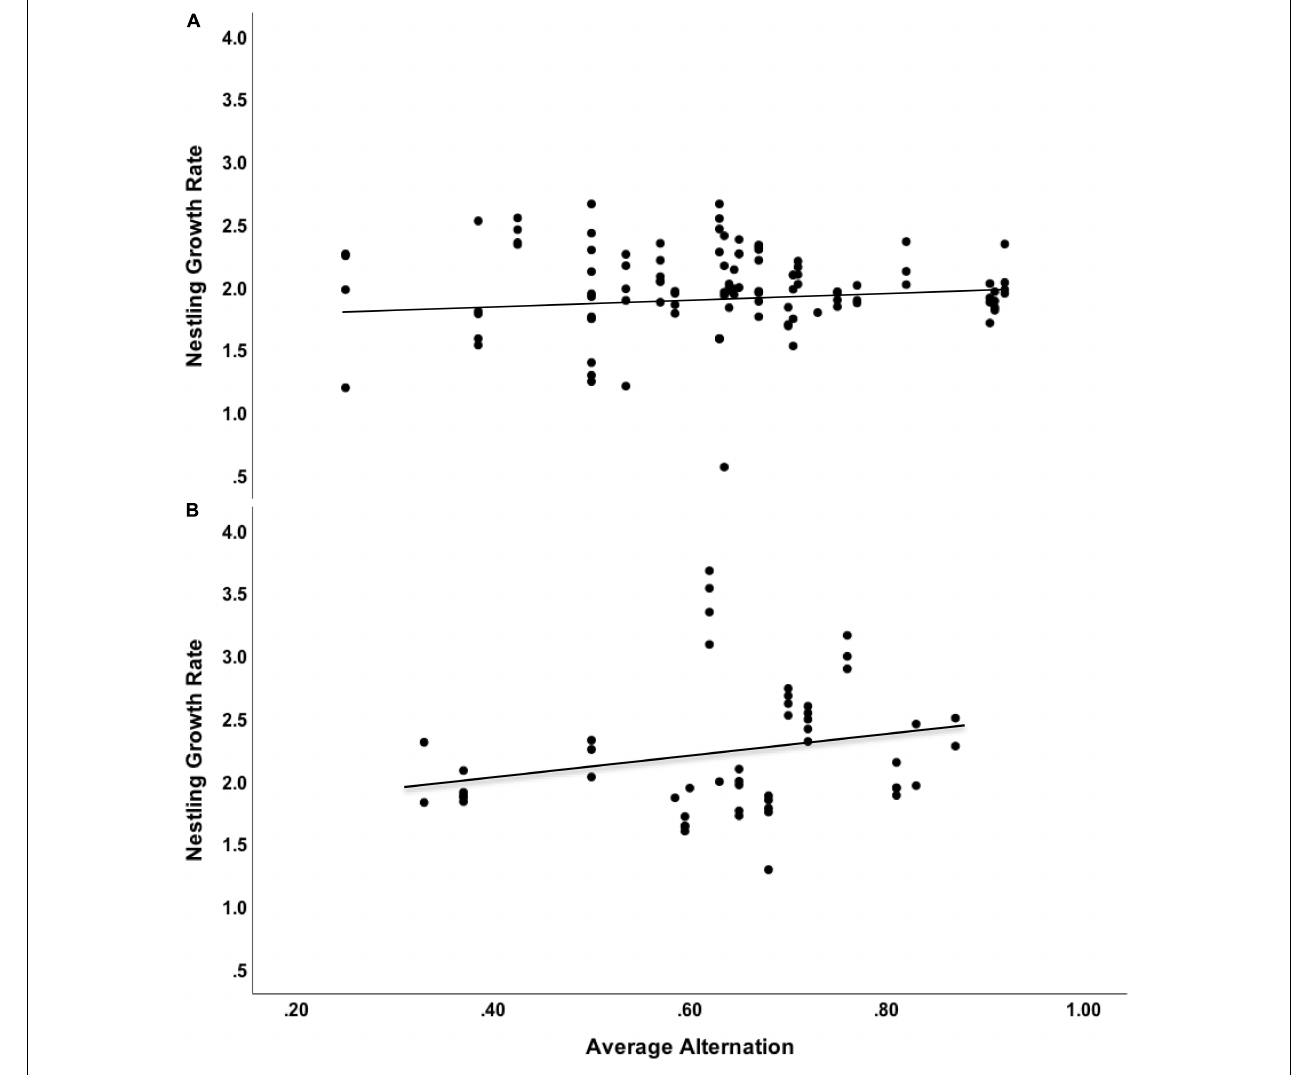
FIGURE 3 | Relationship between average alternation level (proportion of all visits that are alternated within pairs) and nestling growth rate (g/day) of eastern bluebirds, split by areas of low (A) and high (B) density of tree